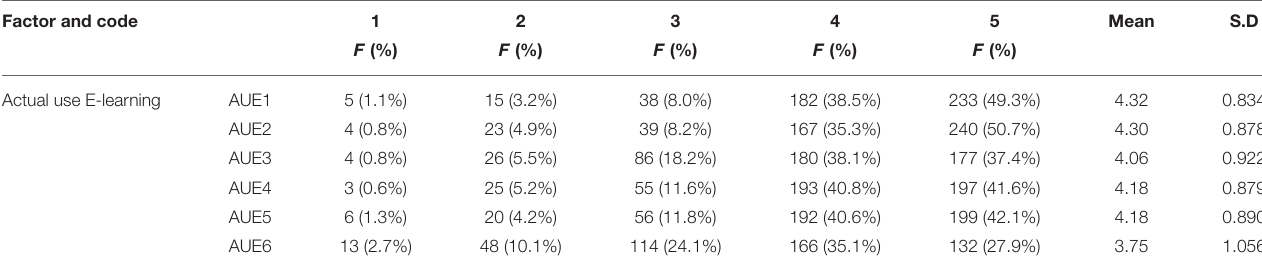
TABLE 12 | Measuring the actual use e-learning system (AUE) as sustainability for education during the COVID-19 pandemic. Factor and